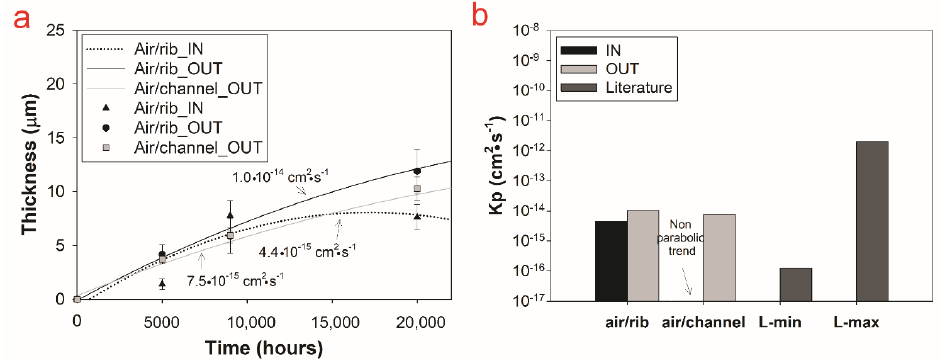
Figure 7. ( a ) example of parabolic growth rate plot that best fits the values of thickness with time; ( b ) values of the Kp for the air side according sampling position (1, 2) and site of interest (IN, OUT) compared to minimum (min) and maximum (max) values found in literature (L).